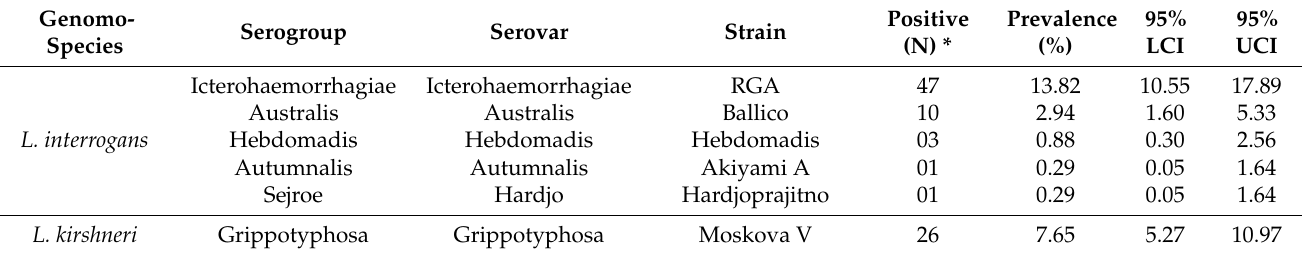
* Cumulative figure of sera positive for various serovars (N = 88) exceed total MAT positive sera ( n = 66) as several sera reacted with multiple leptospiral